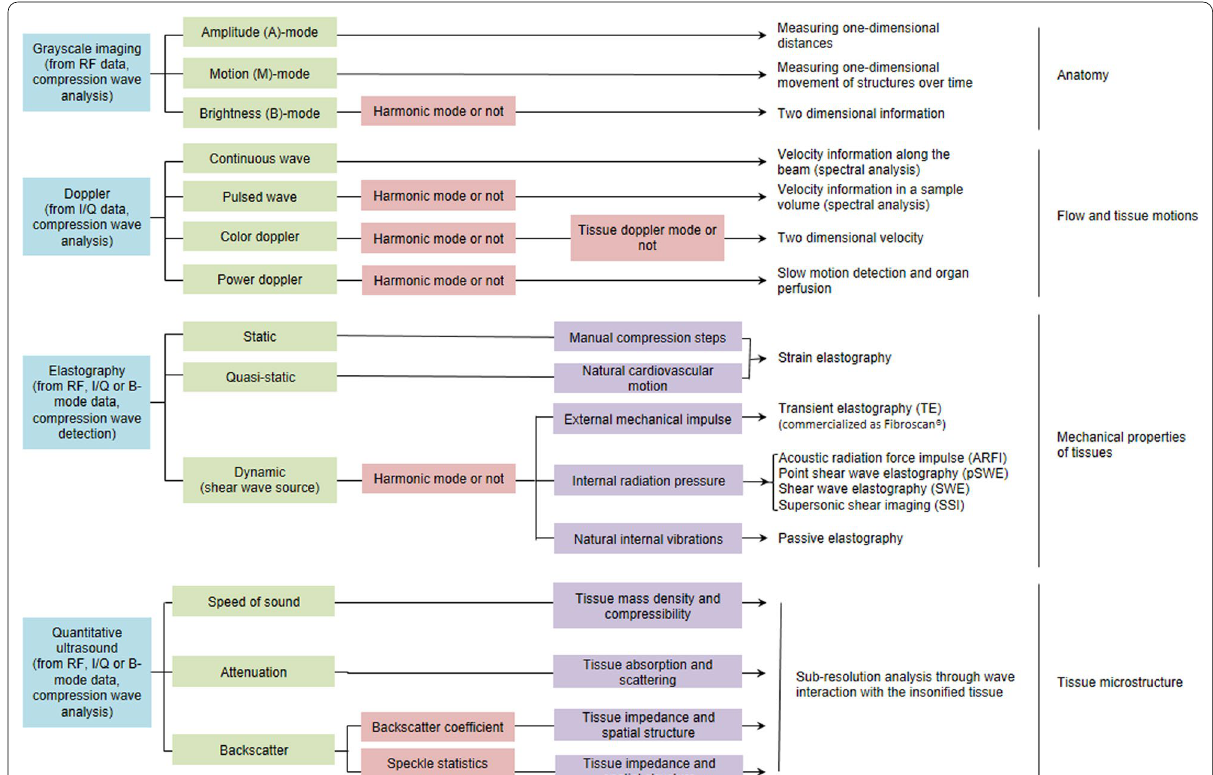
Fig. 1 Classification of ultrasound techniques. From top to bottom, grayscale imaging modes provide information on organ anatomy. Doppler techniques assess flow and tissue motions (direction, velocity, and backscatter in power Doppler mode). Elastography methods provide information on mechanical properties of tissues. Quantitative ultrasound (QUS) detects sub-resolution acoustic properties to provide information on tissue microstructure. RF refers to radiofrequency data, I/Q to in-phase and quadrature data, whereas compression and shear waves refer to elastic waves used in ultrasound